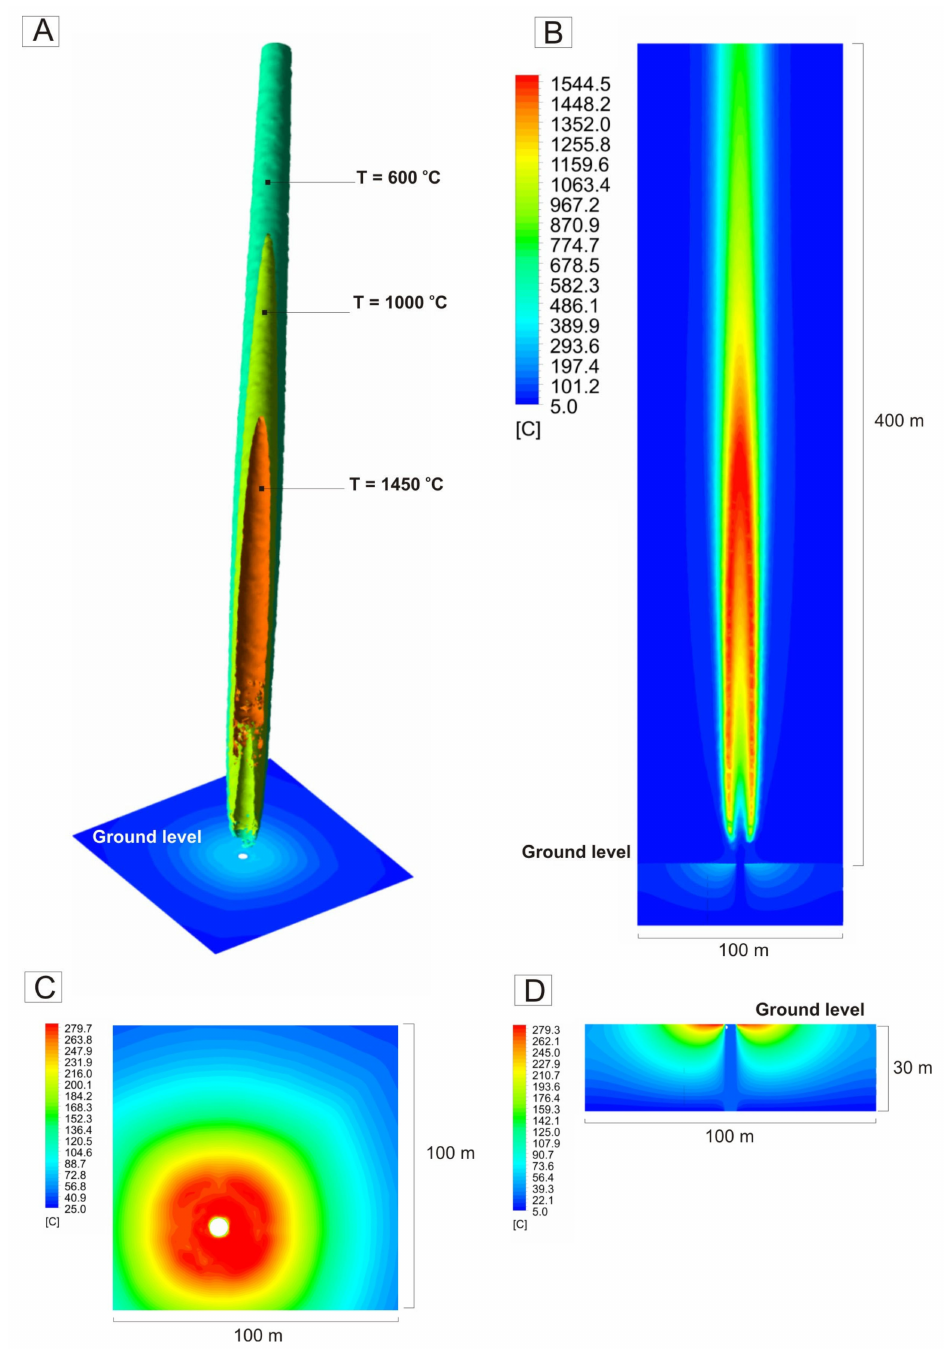
Figure 8. Natural straight-flow vertical gas flare and its temperature pattern. ( A ) Color-coded isothermal surfaces: blue, green, and red colors correspond to temperatures of 600, 1000, and 1450 ◦ C, respectively, and ground temperatures ( ◦ C). ( B – D ) Temperature fields ( ◦ C) in the central section ( B ), on ground surface ( C ), and to 30 m below the surface ( D